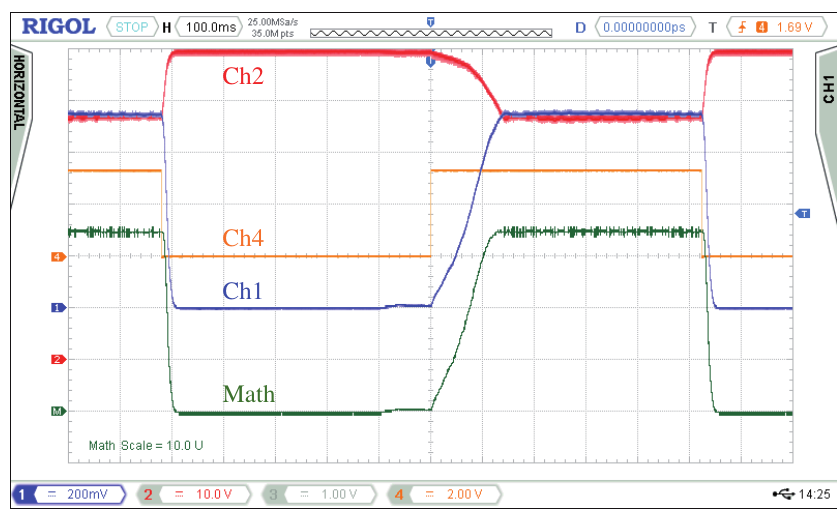
steps between 0 A and 20 A. Ch1: PV bat